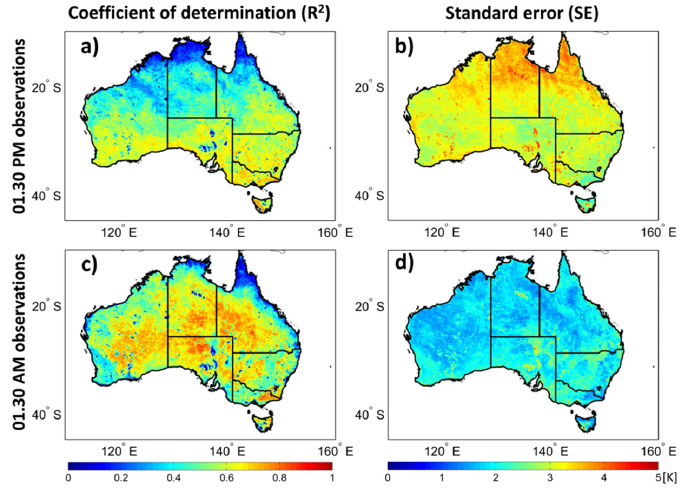
Figure 2. The high agreement between the anomalies Land Surface Temperature products from MODIS and AMSR2 expressed in R 2 ( a ) for day time observations; SE ( b ) for day time observations; R 2 ( c ) for night time observations and SE ( d ) for night time observations.